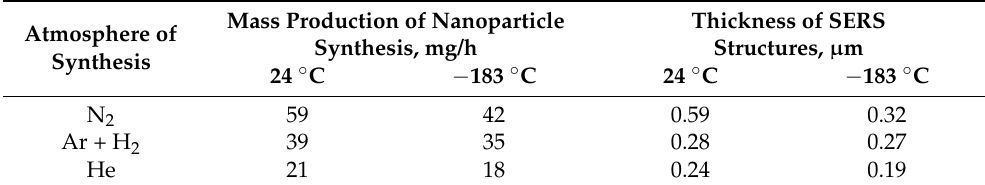
Table 4. Mass production of synthesis and thickness of SERS structures obtained by dry aerosol printing. Synthesis of Au nanoparticles was carried out in nitrogen, argon, and helium at 24 ◦ C and − 183 ◦ C, respectively.